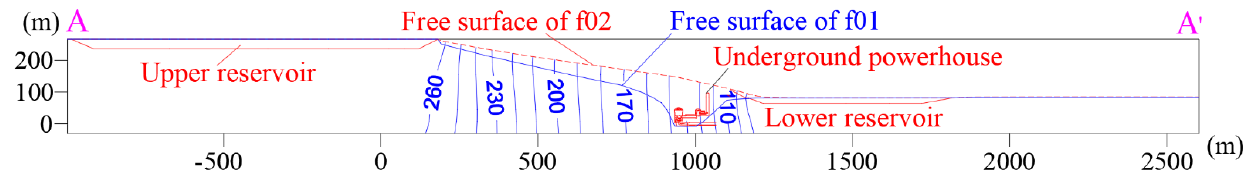
Figure 10. Contrast of free surface contours for schemes f01 and f02. Table 5. Statistical results of hydraulic gradient.